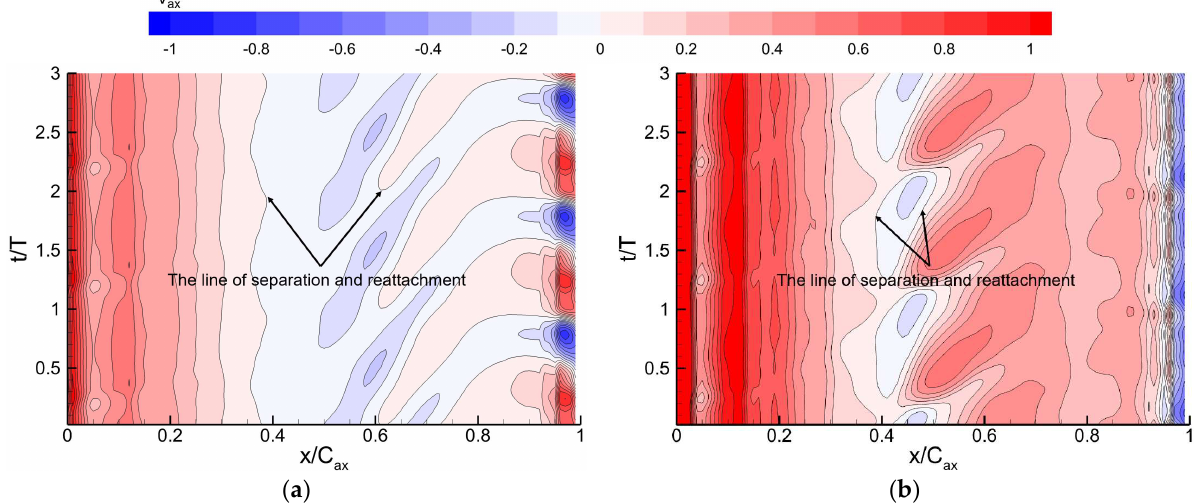
Figure 14. Space-time diagram of axial velocity on the suction surface with the line of separation and reattachment at 50% span. ( a ) Re = 1 × 10 5 ; ( b ) Re = 4 × 10 5 .